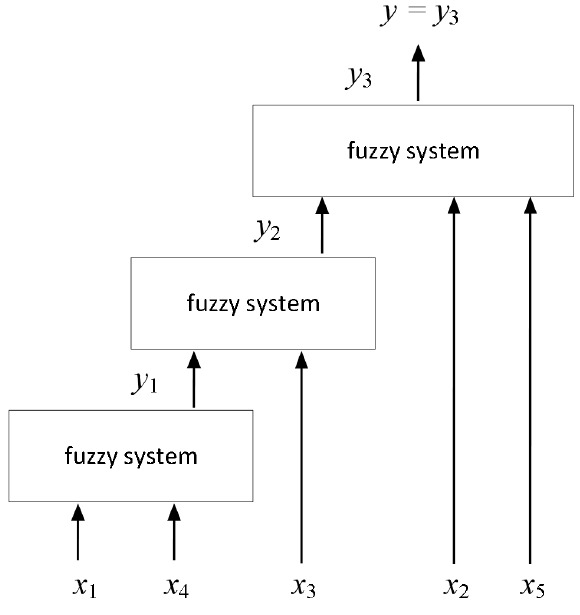
Figure 1. A simple hierarchical fuzzy neural